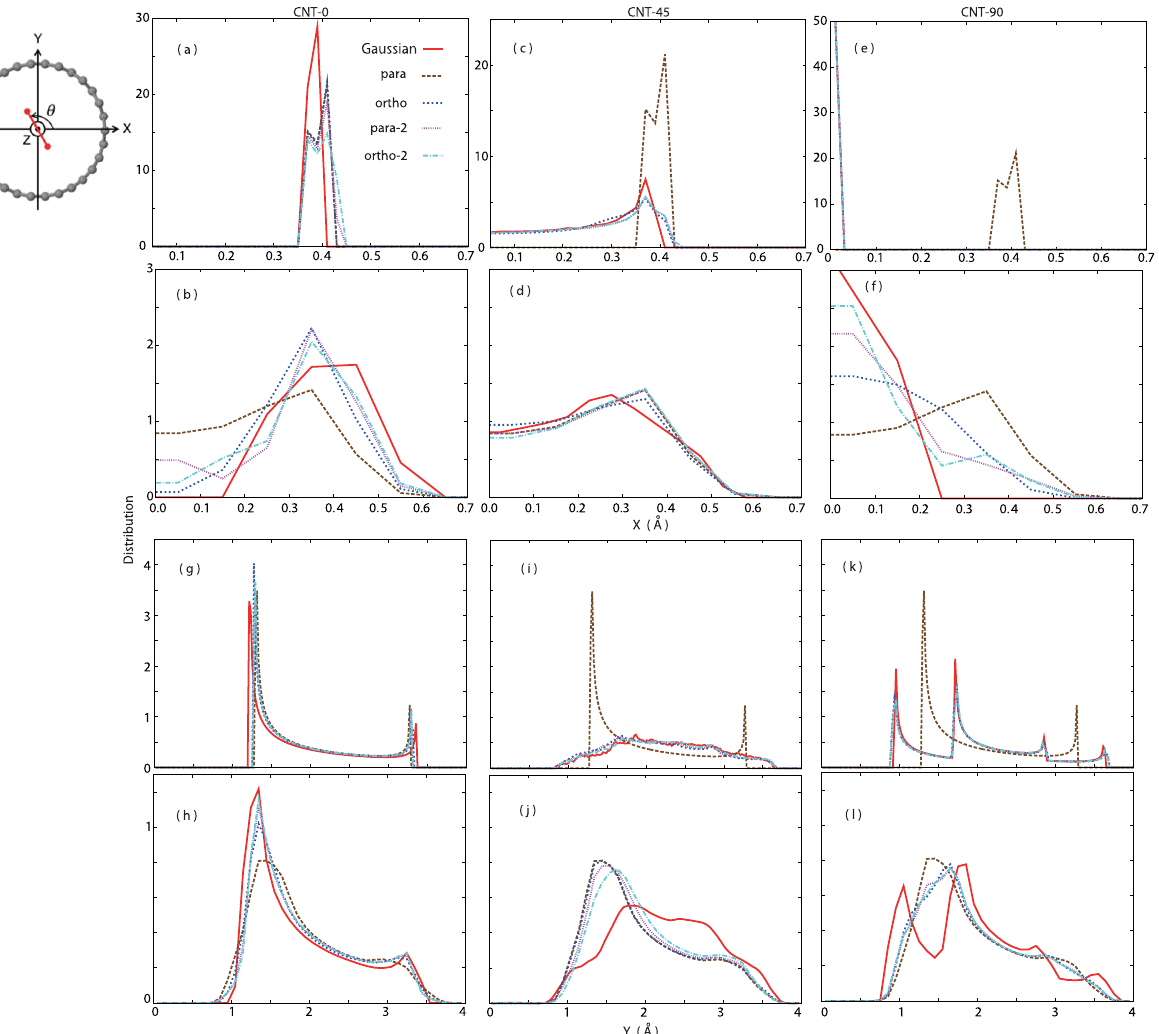
Fig. 3 Spatial distributions of a hydrogen molecule achieved by the collision dynamics taking place inside CNT(15,0). Spatial distributions of Gaussian, para, ortho, para-2, and ortho-2 along the x -axis ( a – f ) and along the y -axis ( g – l ). The initial collision angles between the molecular axis and the CNT(15,0) surface are set as 0 degree (CNT-0: a , b , g , h ), 45 degree (CNT-45: c , d , i , j ), and 90 degree (CNT-90: e , f , k , l ). Panels in the fi rst and third rows show distributions of the NWP center positions R A ( t ) and R B ( t ) along the x - and y -axes, respectively. Panels in the second and fourth rows display corresponding quantum distributions considering the species-dependent NWP delocalization along the x - and y -axes, respectively.